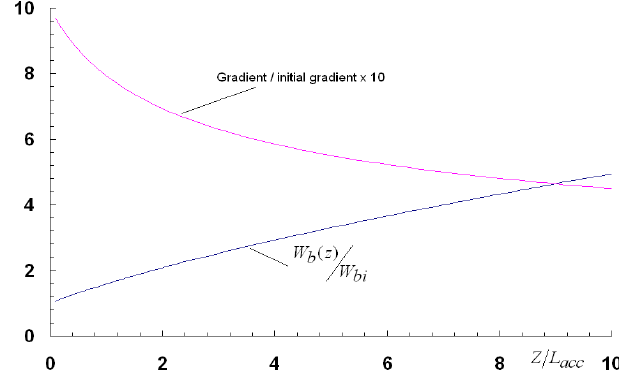
FIG. 13. (Color) Normalized ion energy and normalized gra- for constant impedance tapered pulse line. (Ion dient vs z=L acc energy/initial ion energy in blue, gradient/initial gradient (cid:7) 10 in red.)